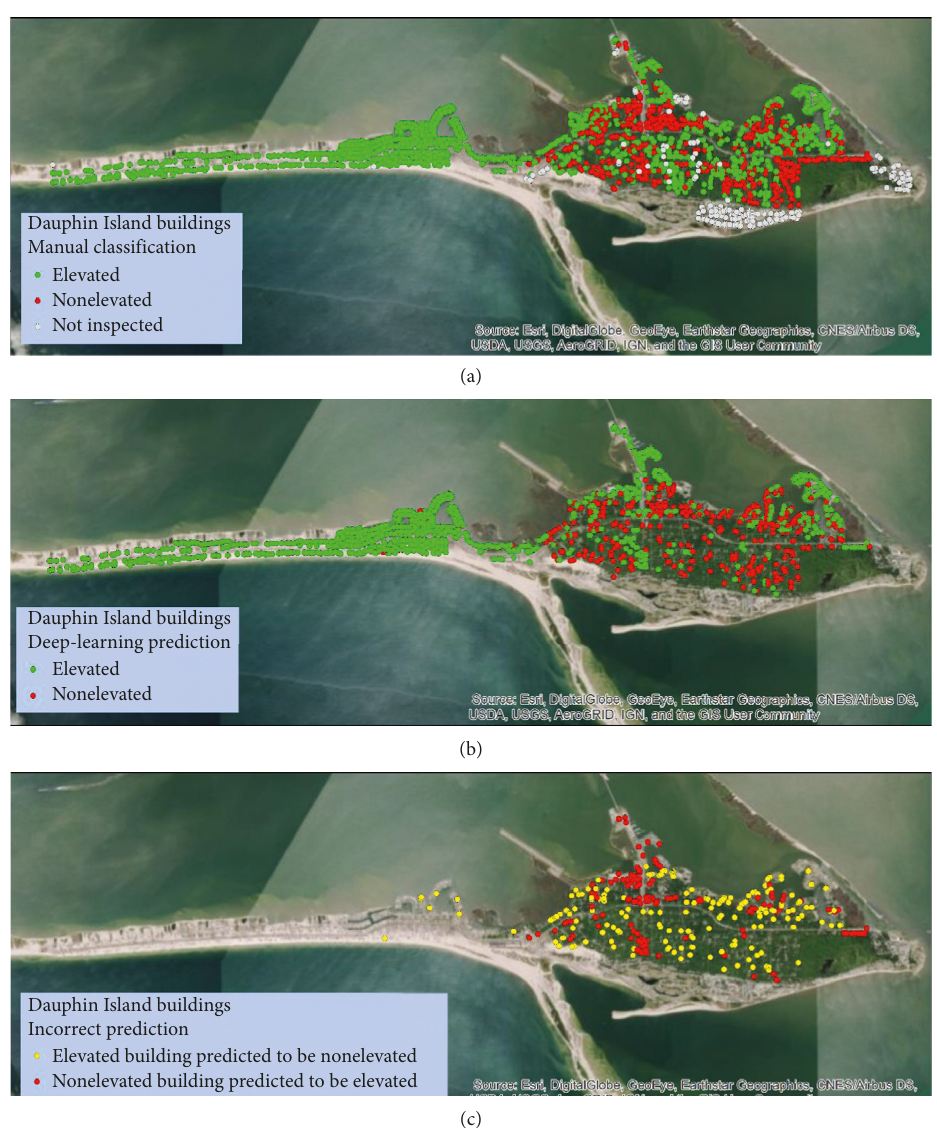
Figure 11: Buildings on Dauphin Island (a) manually classified and (b) predicted by a deep learning model, with (c) incorrectly classified building